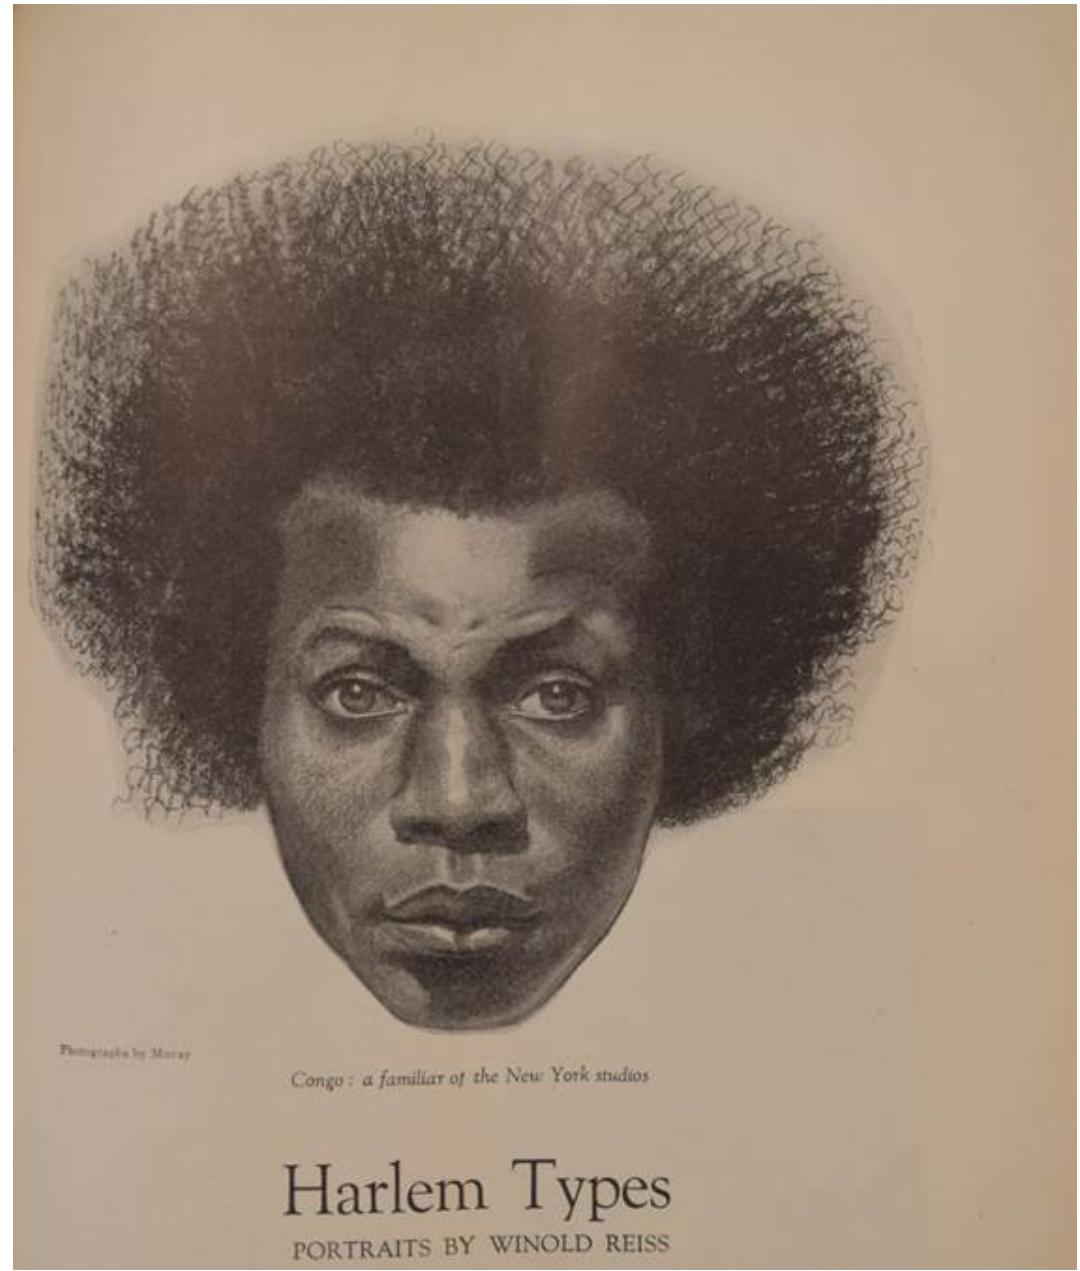
Figure 4 Winold Reiss, ‘Congo: a familiar of the New York studios’, Survey Graphic 6, No. 6 (March 1925), 651 (Courtesy: London School of Economics